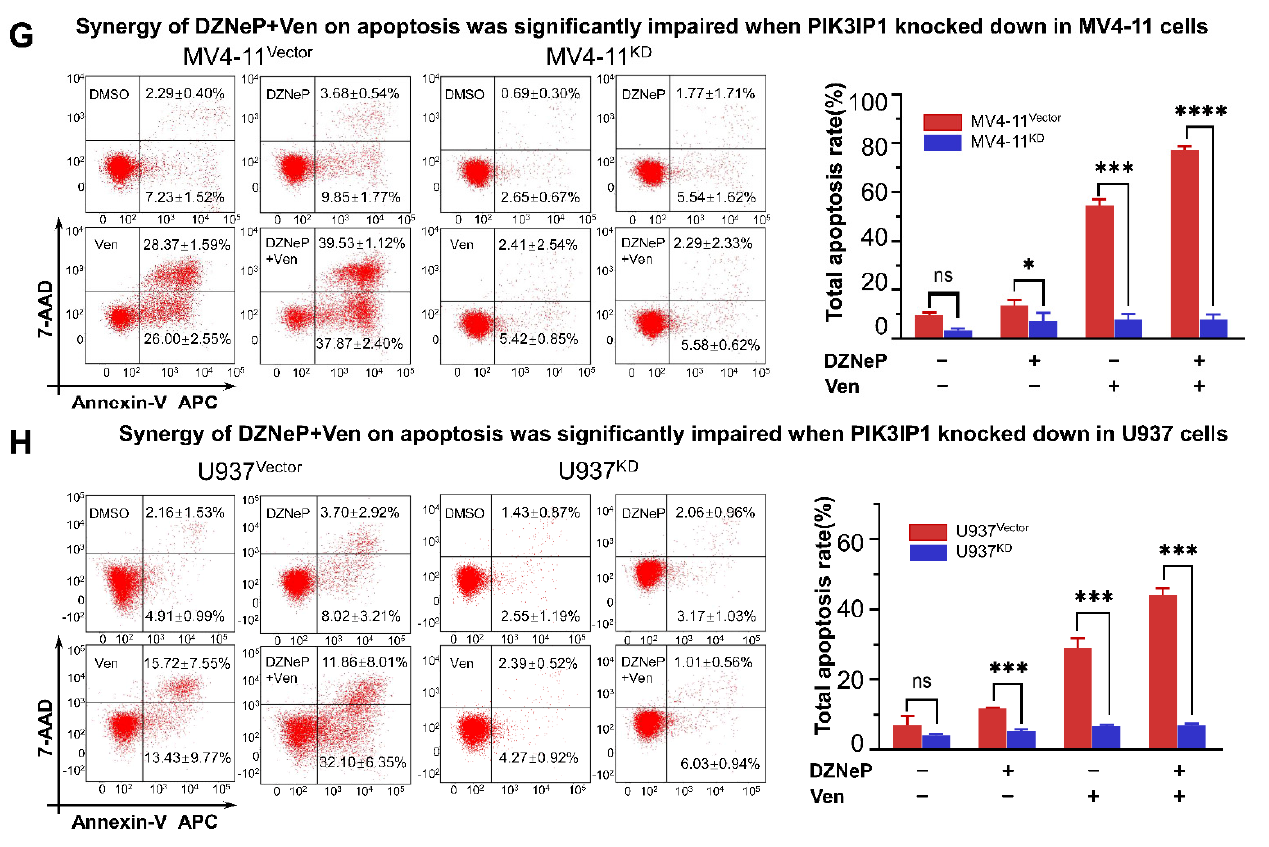
Figure 4. The mechanism of the synergy of co-targeting EZH2 and BCL-2 by DZNeP + Ven is in a PIK3IP1-dependent manner. ( A ) qRT-PCR was used to measure the efficiency of PIK3IP1 knockdown by shRNA in MV4-11 and U937 AML cells. ( B ) Western blot was performed to measure the efficiency of PIK3IP1 knockdown by shRNA in MV4-11 and U937 AML cells. ( C , D ) Effects of the single agents upon proliferation arrest were markedly dampened after PIK3IP1 was knocked down in MV4-11 and U937 AML cells. ( E , F ) Synergistic effects of the combination treatment upon growth inhibition were significantly impaired when PIK3IP1 was knocked down in MV4-11 and U937 cells. ( G , H ) Synergistic effects of the combination treatment upon apoptosis were significantly decreased in PIK3IP1 knockdown cells compared to the vector-transfected cells. ns, no significant. *, p < 0.05. ***, p < 0.001. **** p <